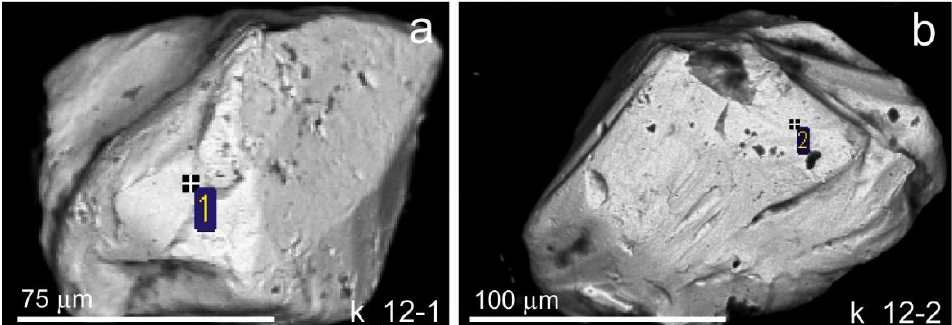
Figure 3. The dodecahedral ( a ) and octahedral ( b ) crystals of Khokhoy ore field. Mounted polished sections, scanning electronic microscope in back-scattering electron mode. The numbers in microphotographs are analitical spots, here and in other figures. Table 2. The composition (in wt%) and fineness (in ‰ ) of the supergene gold shown in Figures 3, 4, 8 and 10.